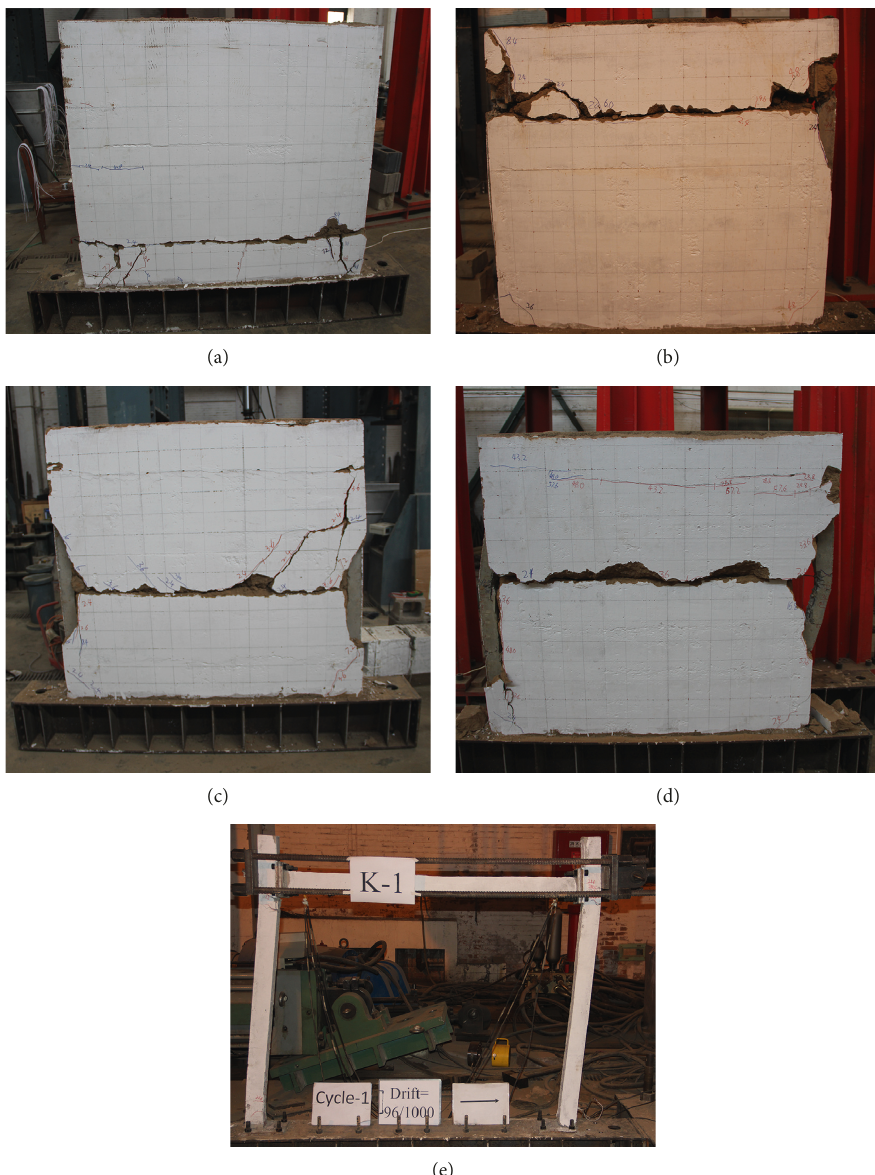
Figure 7: Failure mode of tested specimens. (a) Specimen Q-1. (b) Specimen Q-2. (c) Specimen Q-5. (d) Specimen Q-7. (e) Specimen